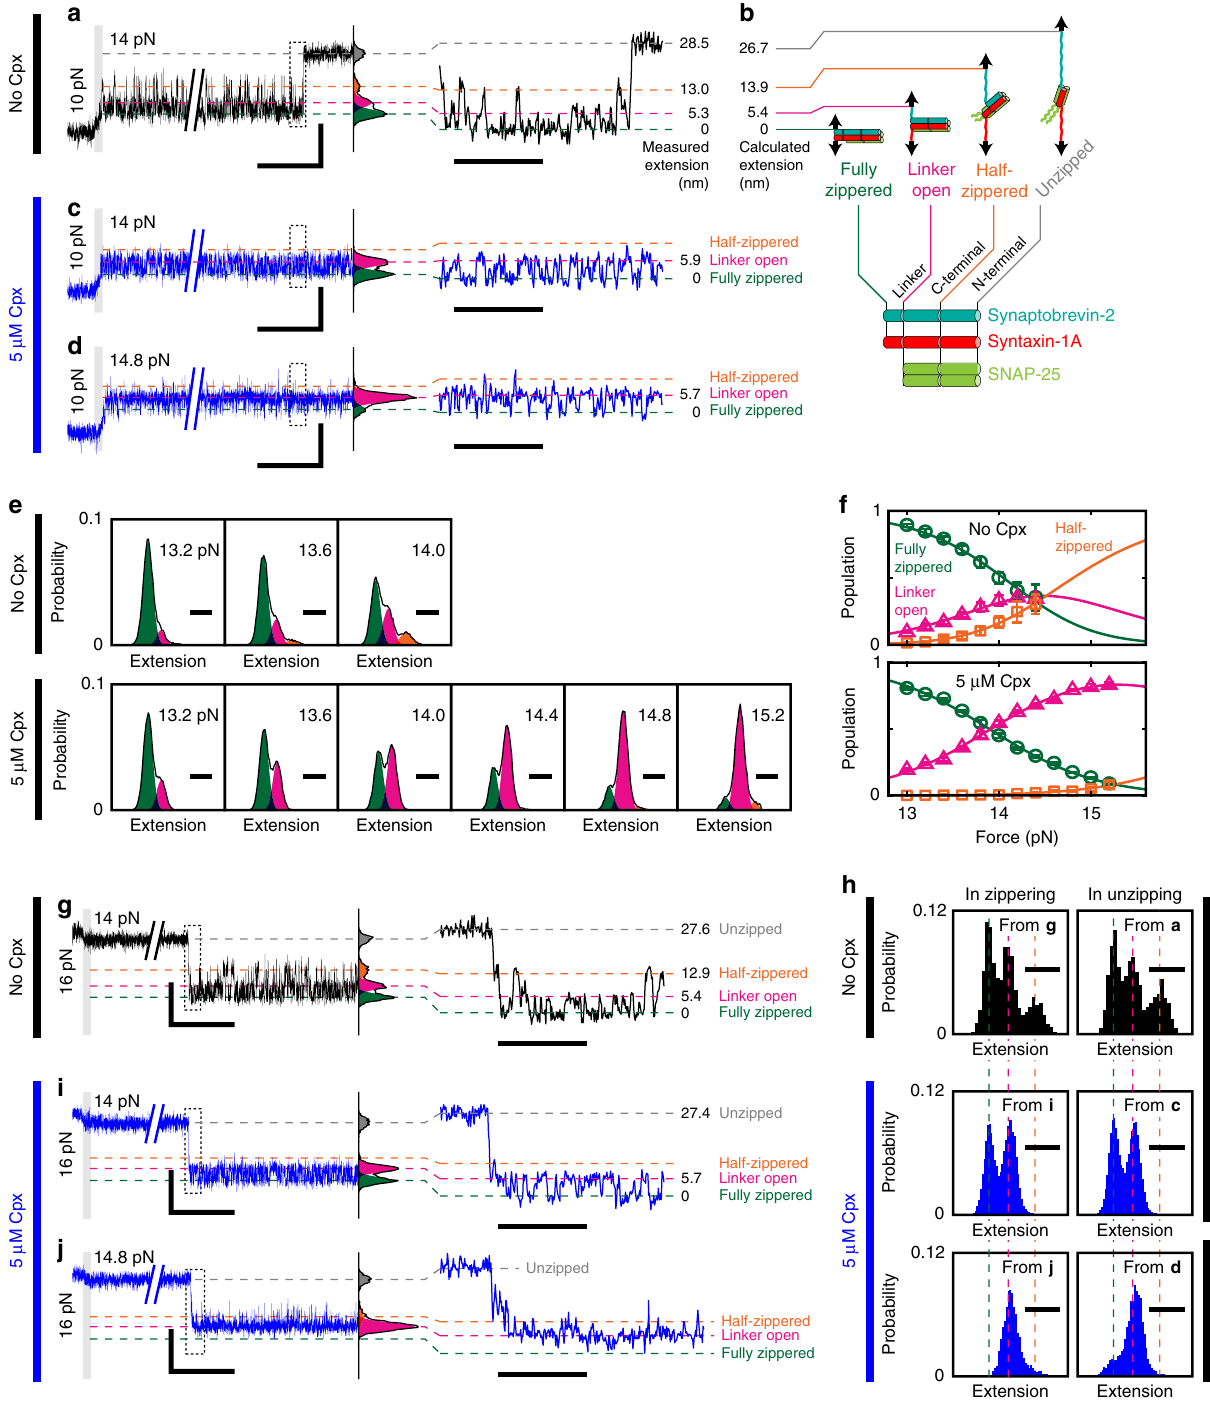
Fig. 3 Complexin promotes the linker-open state of neuronal SNARE complexes. a , c , d High-speed observations (1.2 kHz) of the conformational intermediates during the unzipping of a SNARE complex. The measured distributions of extensions (black lines displayed to the right of the traces) are overlaid with their identi fi ed Gaussian components color-coded green, magenta, orange, and gray from the lowest. Dotted areas are magni fi ed on the right. The locations of the peaks are indicated with dashed lines of the same color and with numbers. b A model for the intermediate conformations of a SNARE complex with calculated values of extension. e Force-dependent shifts in extension distribution with the indicated Gaussian components. The color code is the same as in a – d . f Force-dependent equilibria among the three zippered conformations in the absence (upper) and presence (lower) of Cpx. Solid lines represent the fi ts to a three-state equilibrium model (Supplementary Note 5). Data are represented as mean ± s.d. of more than three measurements. g , i , j High-speed observations of the conformational intermediates during the zippering of a SNARE complex. The color code is the same as in a – f . h Comparisons of conformational equilibria during unzipping (upper; 10 → 14 pN) and zippering (lower; 16 → 14 pN) of a single SNARE complex. In all panels, vertical scale bars represent 20 nm. Horizontal scale bars represent 1 and 0.1 s (on left and right in a , c , d , g , i , j , respectively), and 10 nm (in e , h